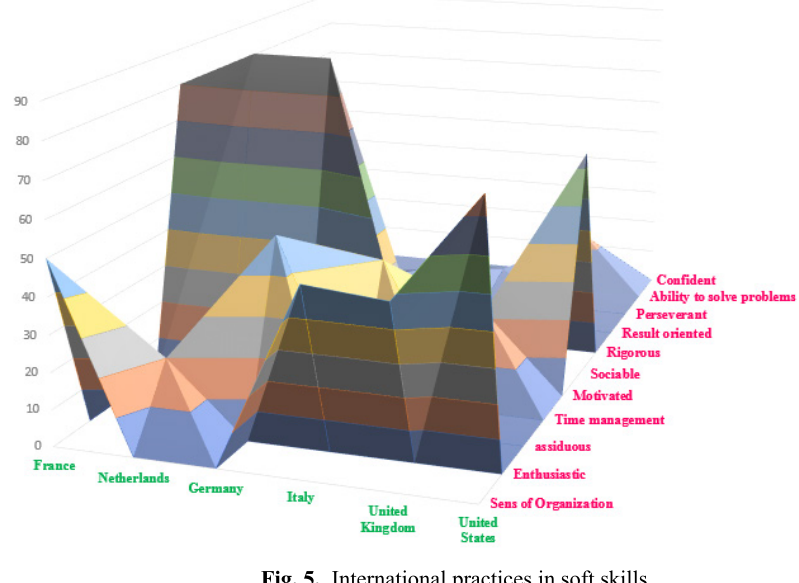
Fig. 5. International practices in soft